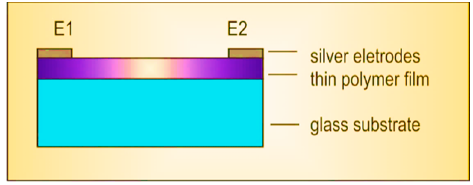
Figure 2. Arrangement of electrodes for measuring electrical resistance.